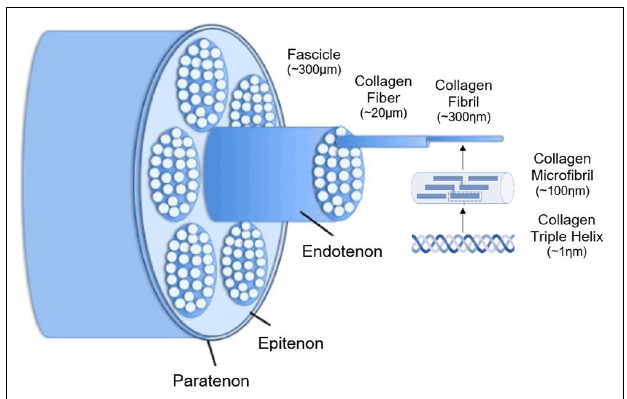
FIGURE 1 | Schematic illustration of the hierarchical structure of tendons. Adjusted from Durgam and Stewart (2016) and ChemBAM (n.d.).